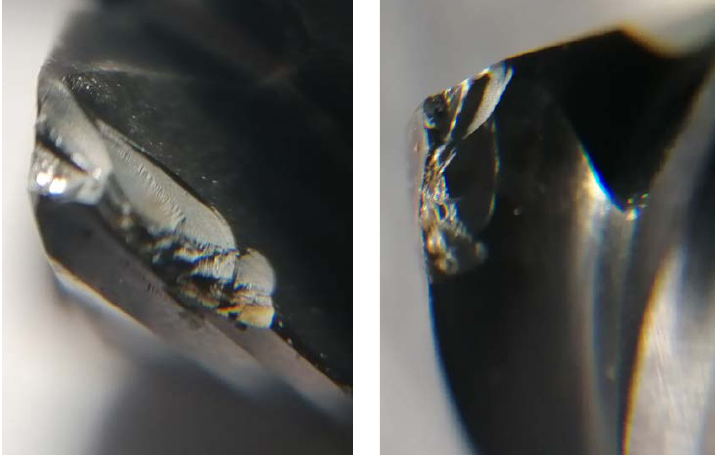
Figure 17. Brittle fracture tool wear occurring during machining. Magnification × 12.